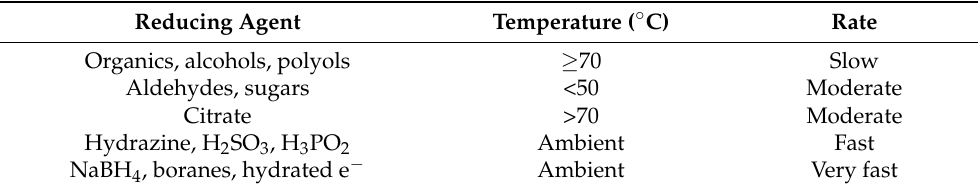
Table 1. Common reducing agents and the reaction conditions, adapted from Bonsak [62] and Rana et al.